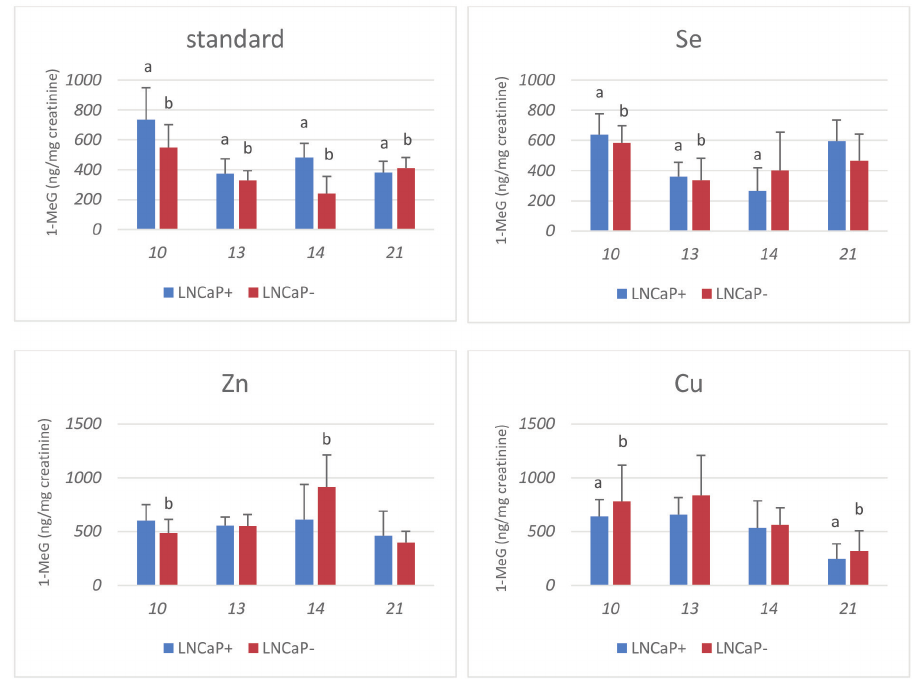
Figure 4: The effect of Se, Zn and Cu supplementation on the excretion of urinary 1-methylguanine (ng/mg creatinine) (10-13-14-21 week) in rats treated and non-treated with prostate cancer cells. a – groups implanted cancer cells; group fed standard diet versus groups fed diet with addition of trace elements (p≤0.05). b – groups non-implanted cancer cells; group fed standard diet versus groups fed diet with addition of trace elements (p≤0.05). * - implanted versus non-implanted cancer cells rats